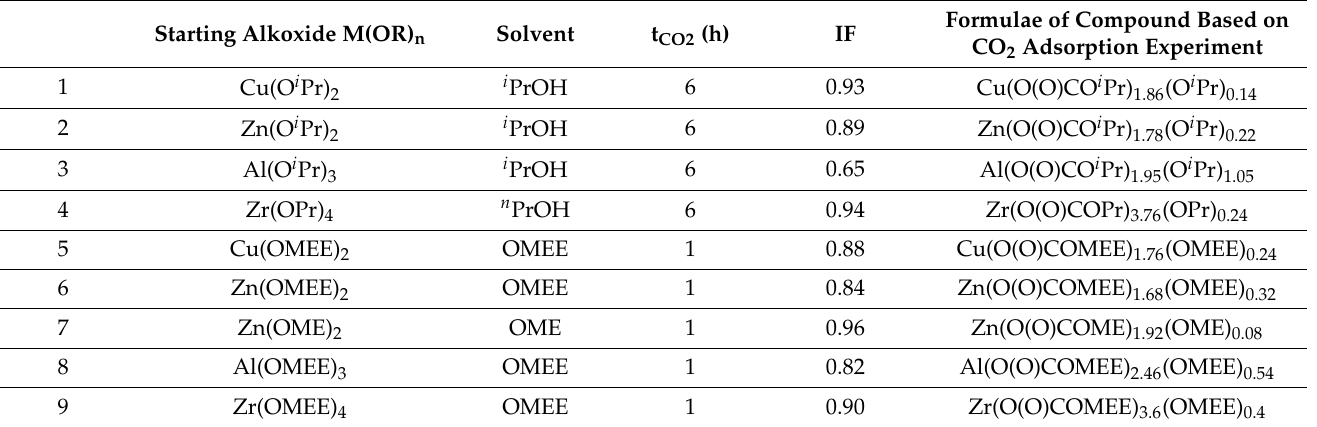
Table 4. Insertion factor for different metal alkoxides, n [alkoxide] = 40 mmol, V[CO 2 ] = 2 L · min − 1 , n [solvent] = 6 mol, T = 313